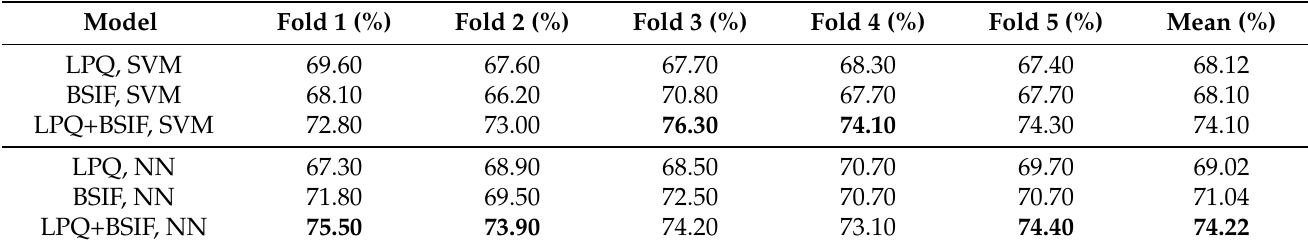
Table 2. The accuracy results of LBQ and BSIF descriptors and their combination using SVM and NN classifiers on Kather-CRC- 2016 database.